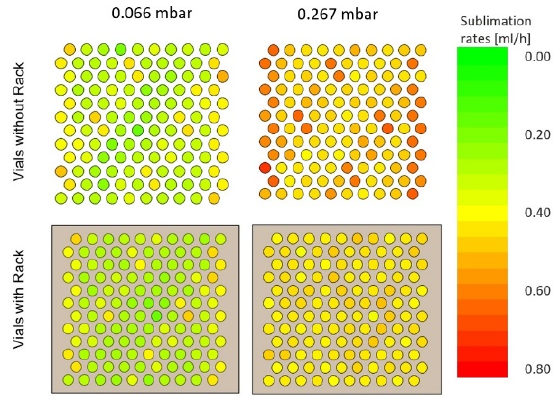
Figure 8. Sublimation rate mapping for vials with and without a rack at 0.066 mbar and 0.267 mbar.